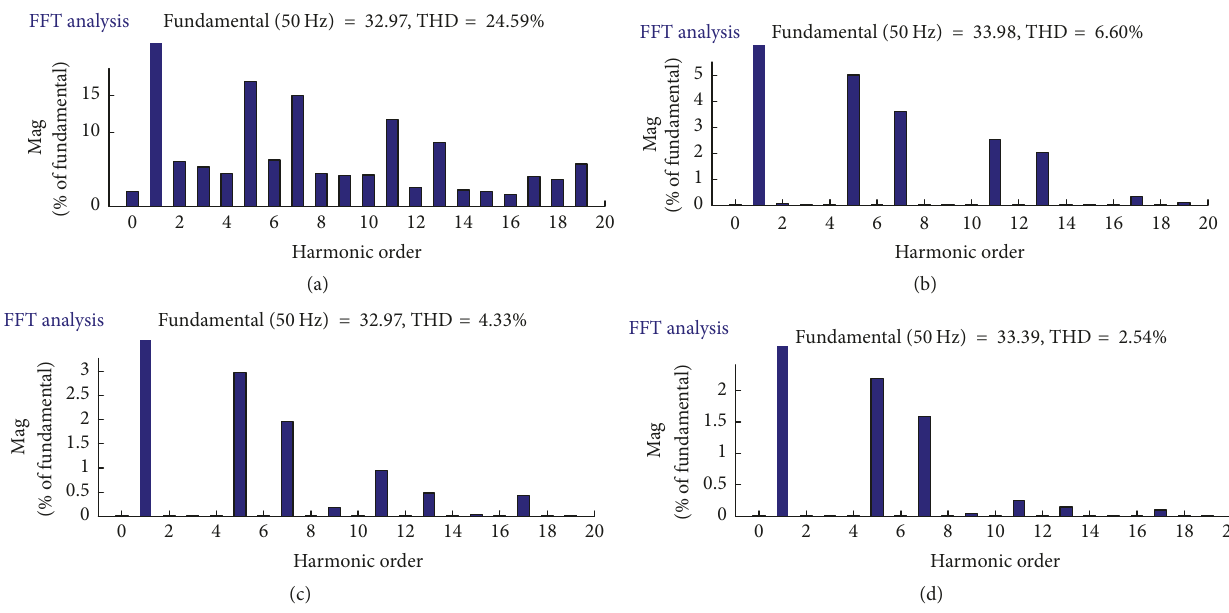
Figure 6: Spectrum analysis comparison. (a) Spectrum analysis of load current without decoupling method. (b) Spectrum analysis of load current with feedforward decoupling method. (c) Spectrum analysis of load current with inverse system decoupling method. (d) Spectrum analysis of load current with generalized inverse system decoupling